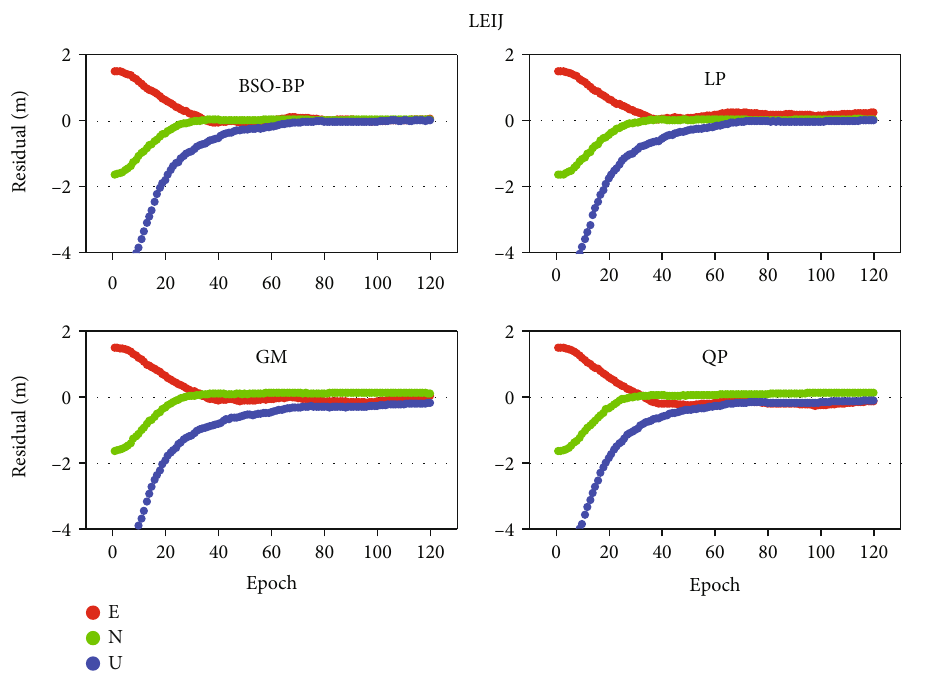
Figure 17: Residuals of the static PPP base on four clock model for